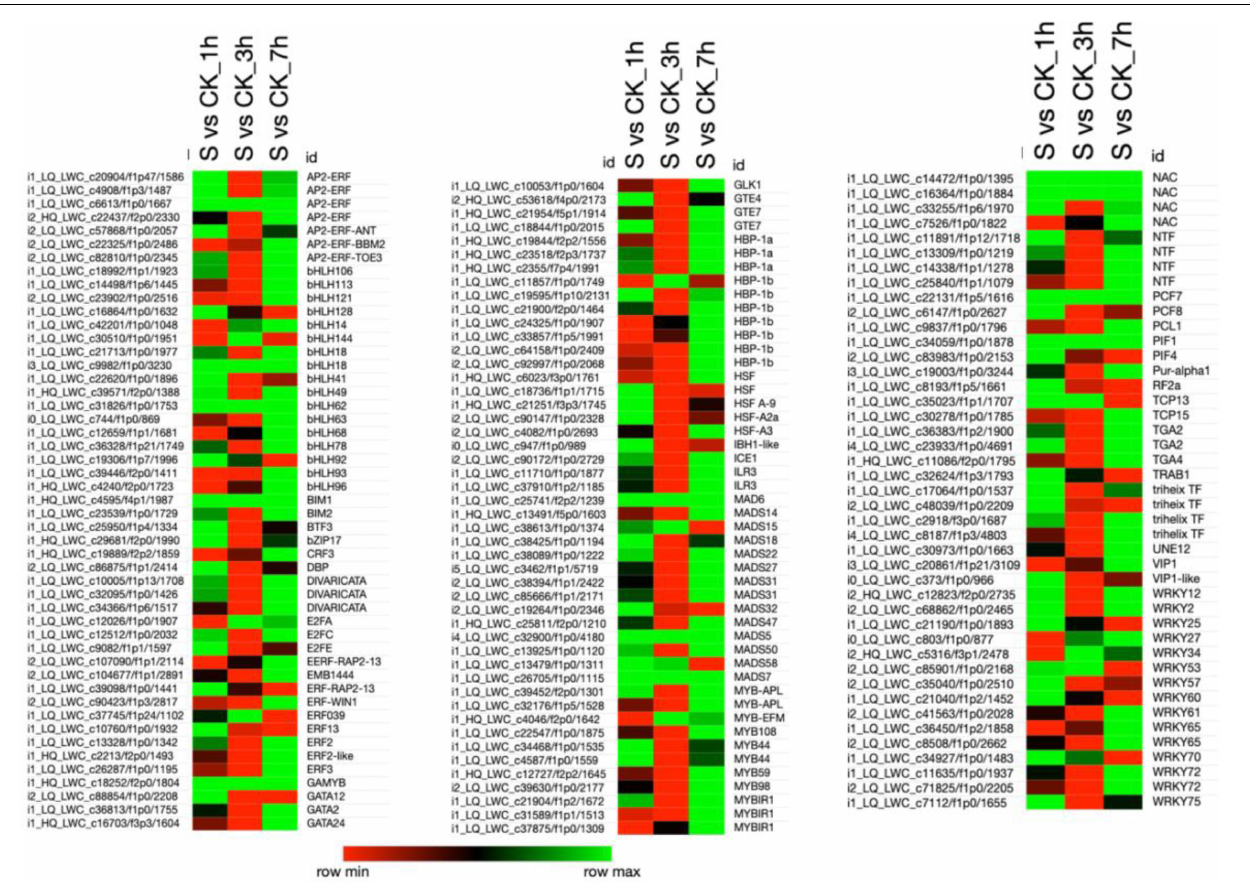
FIGURE 8 | This figure shows the heatmap that represents the differentially expressed transcription factors (TFs) that belong to different TF families in pearl millet and are expressed under salt stress. The data of TFs were retrieved from the plant transcription factor database (PTFDB) (http://planttfdb.gao-lab.org/). Here, the green color in the heatmap shows the upregulation of TFs and the red color shows the downregulation when the TFs were compared among various combinations as mentioned on the top of each column. Moreover, “S” indicates salt-treated groups, “CK” indicates the control group, and “h” is used for hours, i.e., 1 hour (1 h), 3 hours (3 h), and 7 hours (7